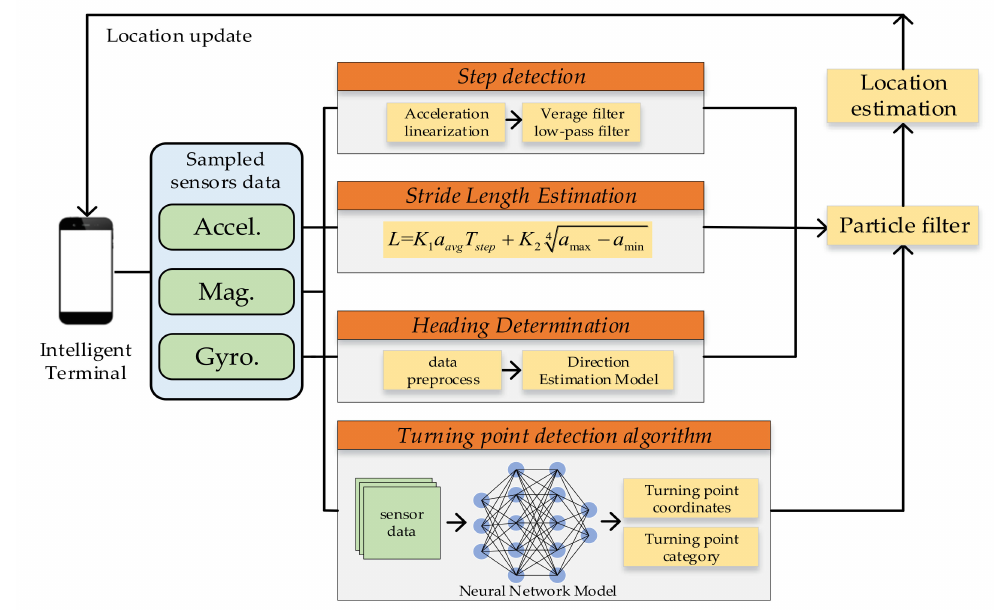
Figure 5. Positioning system architecture